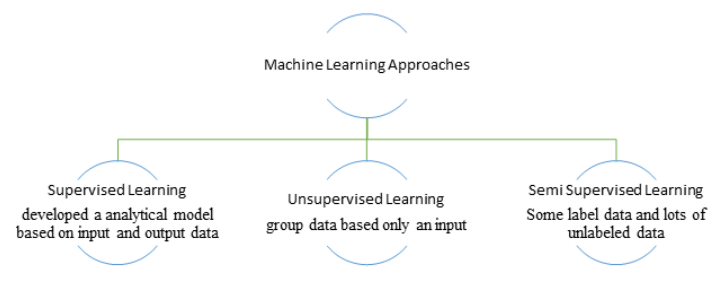
Figure 5. Machine Learning